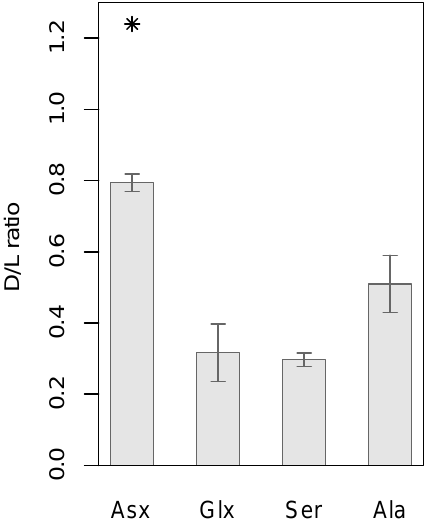
Figure 7. Mean amino acid D / L ratios on day 32 of the incubations. Means and standard deviations were calculated from all samples on day 32 ( n = 6). Asx did not include the artificial Arctic sample, which had a considerably higher D / L ratio than the rest of the sam- ples (indicated with a